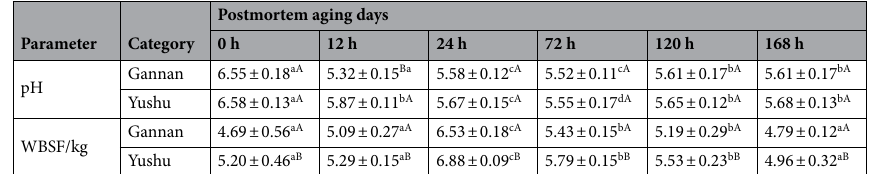
Table 1. Changes in quality characteristics in Gannan Yak and Yushu Yak LL muscle tissues during postmortem aging at 4 °C (0, 12, 24, 72, 120, and 168 h). a-e Means without shared superscripts in a row differed significantly ( P < 0.05). A-B Means without shared superscripts in a column for a given parameter differed significantly ( P < 0.05).